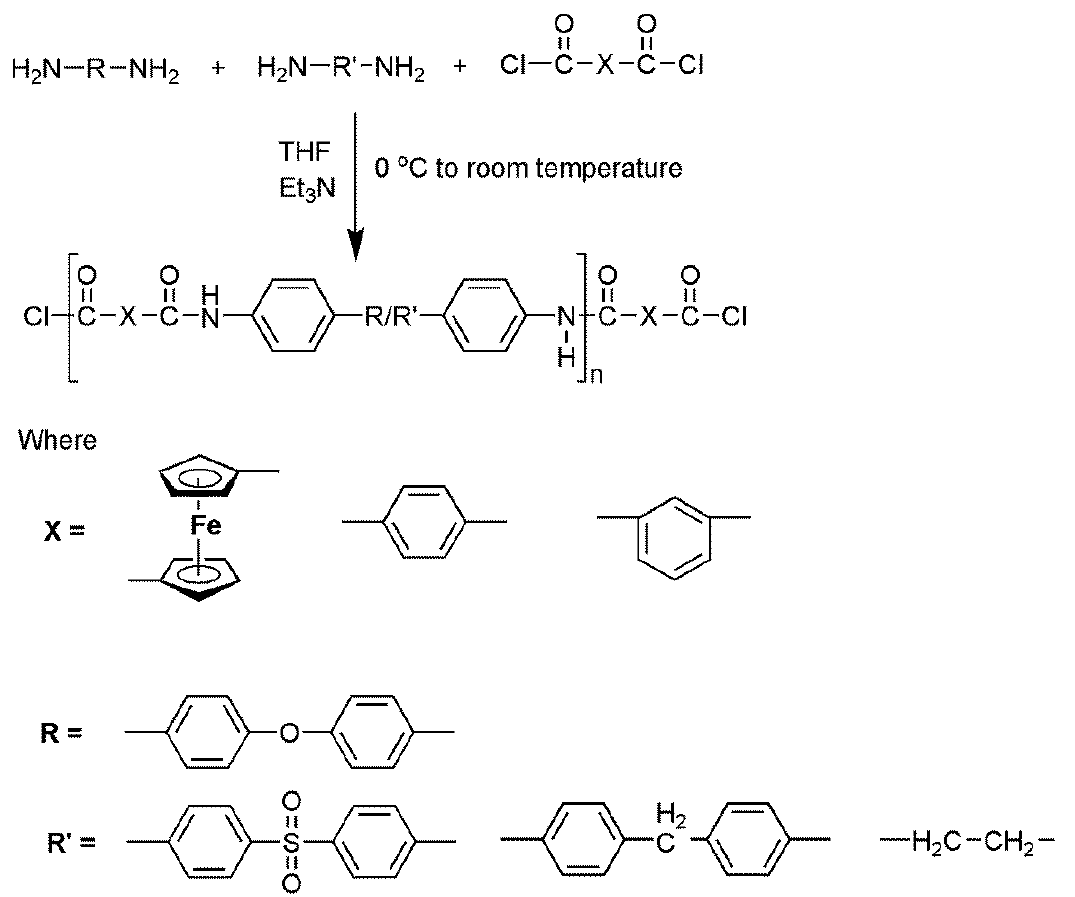
Figure 2. Synthesis of ferrocene-based aromatic terpolyamides and their organic analogs.